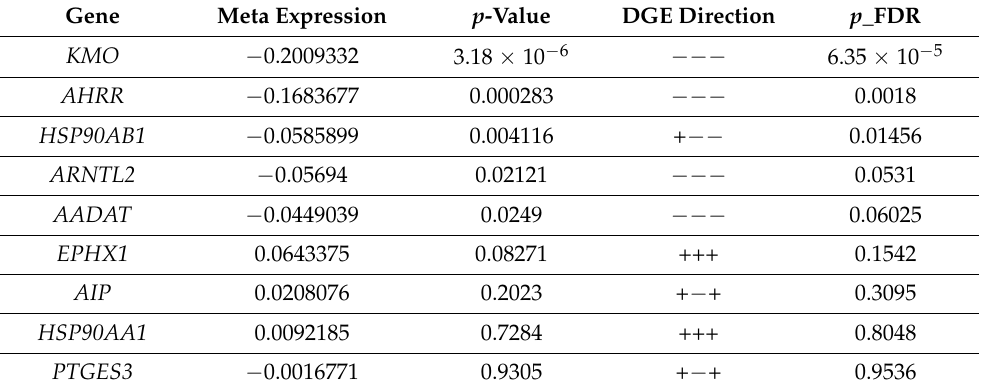
Table 1. Transcriptome ‐ wide association study (TWAS) for AHR ‐ signaling ‐ related genes in human LOAD cohorts.